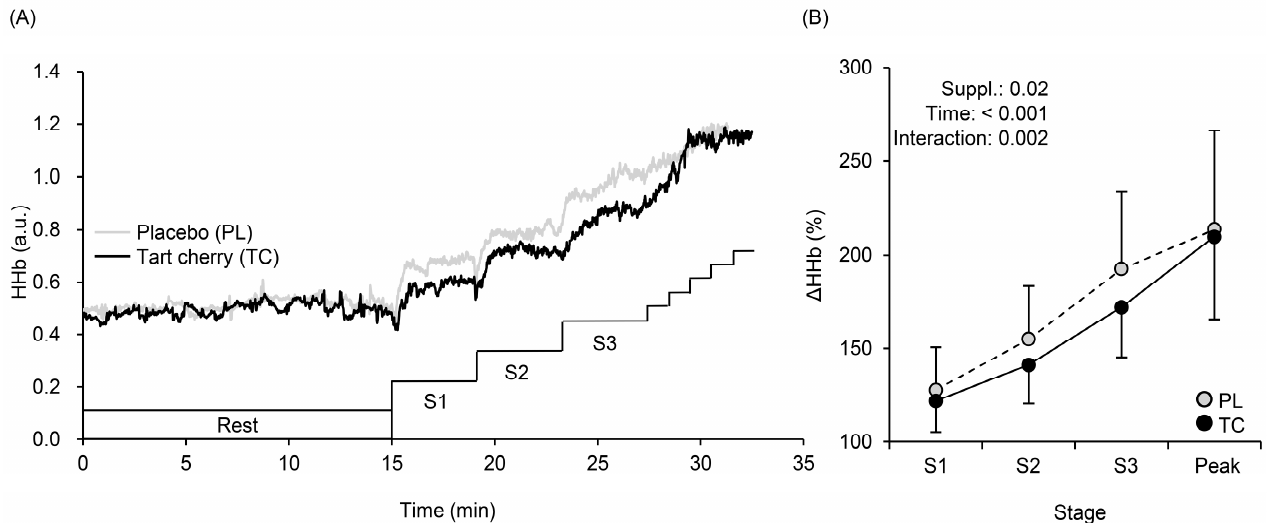
Figure 3. The typical time course changes in muscle deoxygenation (HHb) profiles at rest and during exercise ( A ). Changes in mean HHb with SD obtained at rest, at each stage (S1, S2, S3), and at exercise exhaustion (Peak) after 5 days of tart cherry (TC) and placebo (PL) supplementation ( B ). Suppl., supplementation; S1–S3, Stages 1–3.